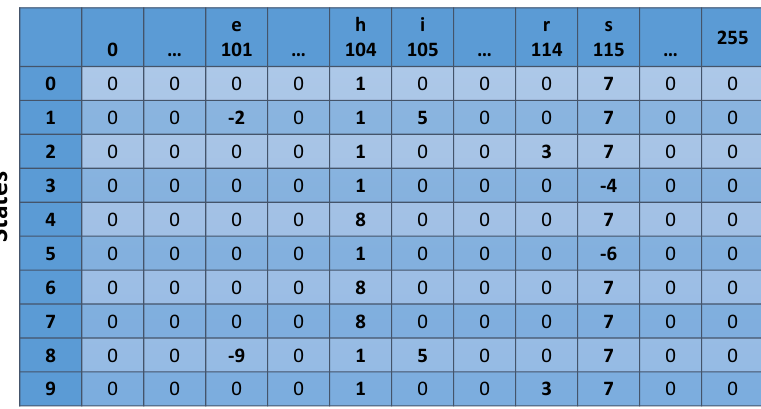
Figure 3. The state table produced by the serialization of the Aho–Corasick DFA as a two-dimensional integer array. Negative values indicate final